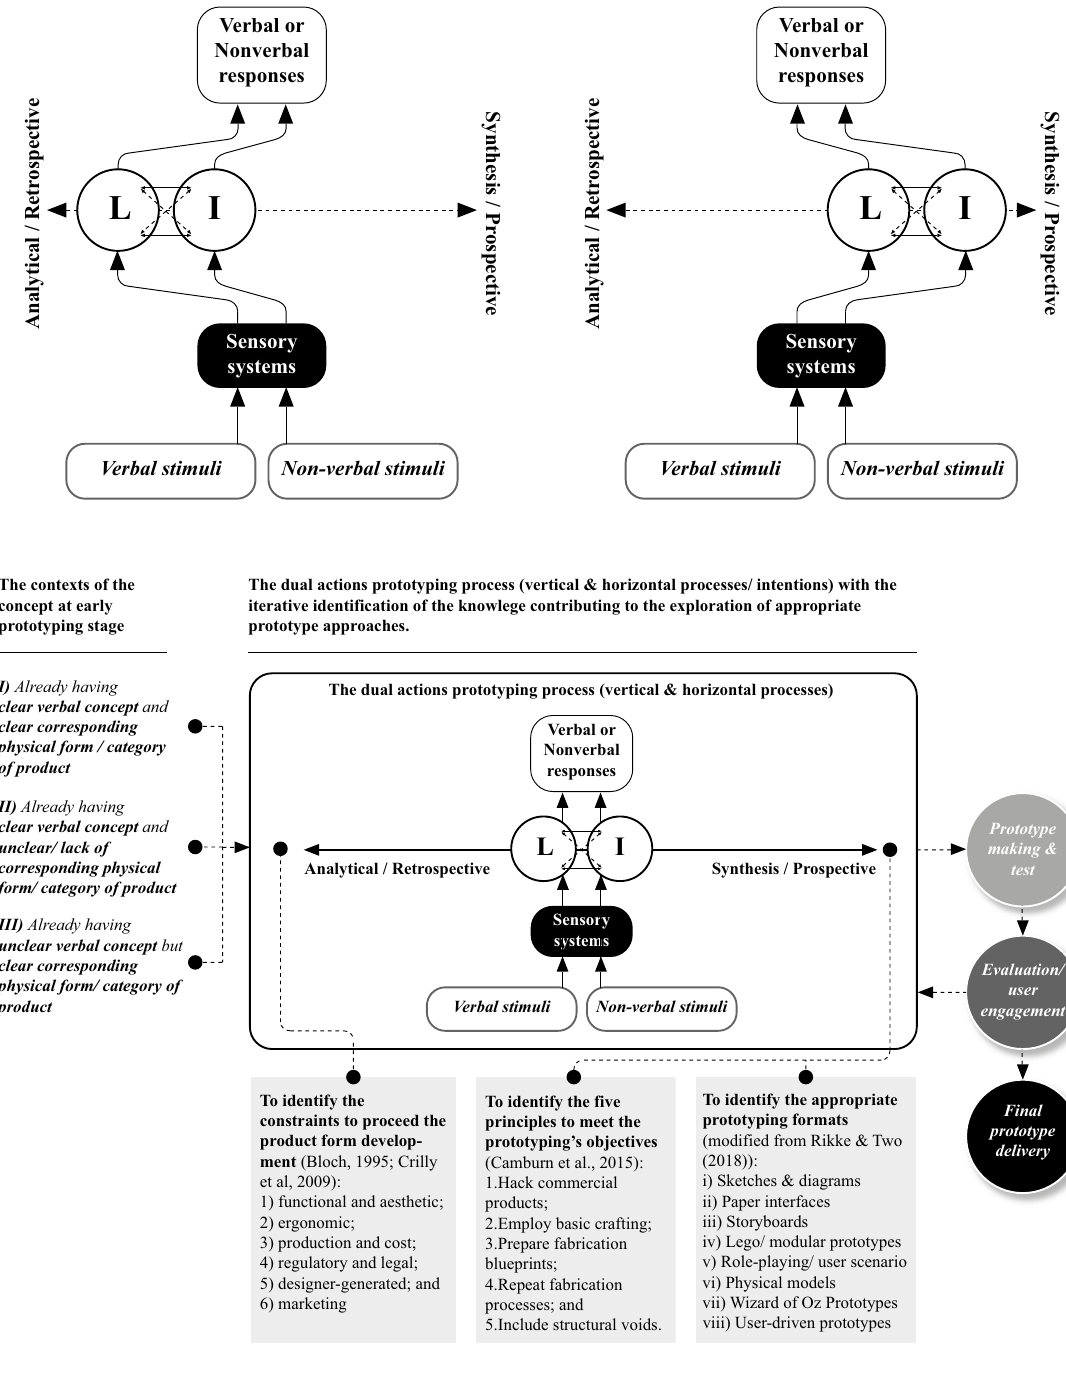
Figure 4 (bottom): The dual actions prototyping processes framework. It demonstrates how consideration of